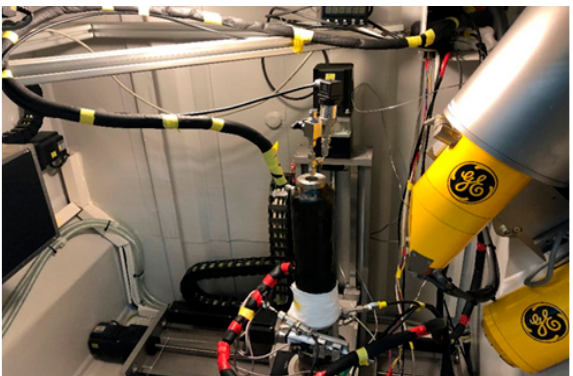
Figure 2. Photo of reactor, axial loading device and CT scan. This is the local enlarged image of the window in Figure 1. In the center, the black cylinder is the axial loading device seated on the turntable; the yellow cylinders are sets of X-ray source. The core holder can rotate 360° with the turntable during CT scan, so a three-dimensional image can be obtained.